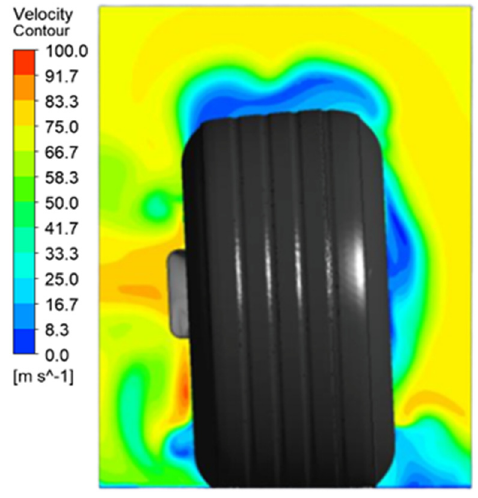
Figure 8. Velocity contours on plane X2.